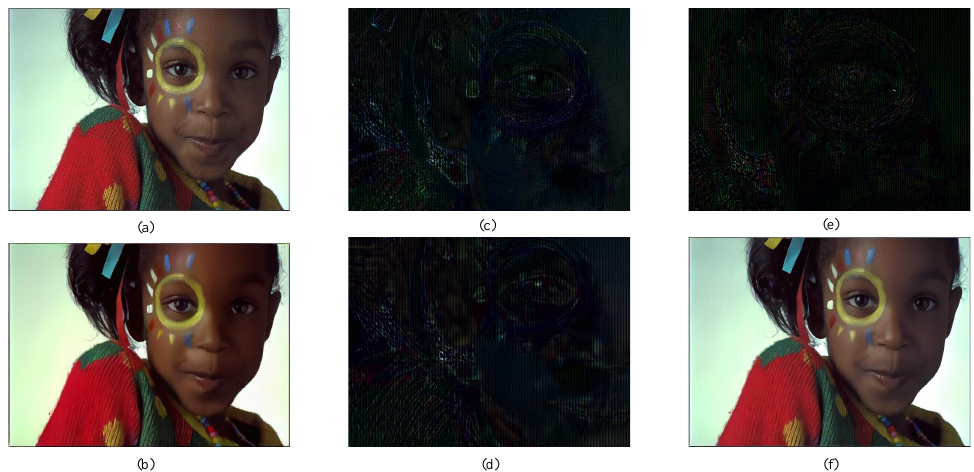
Figure 11. Process of global residual learning: ( a ) original x ; ( b ) main information ˜ x ; ( c ) residual ∆ x ; ( d ) reconstructed residual ∆ ˜ x ; ( e ) remained residual ∆ x (cid:48) ; and ( f ) reconstruction x (cid:48) = ˜ x + ∆ ˜ x . Note that for better visualization, salient region of the residual image was